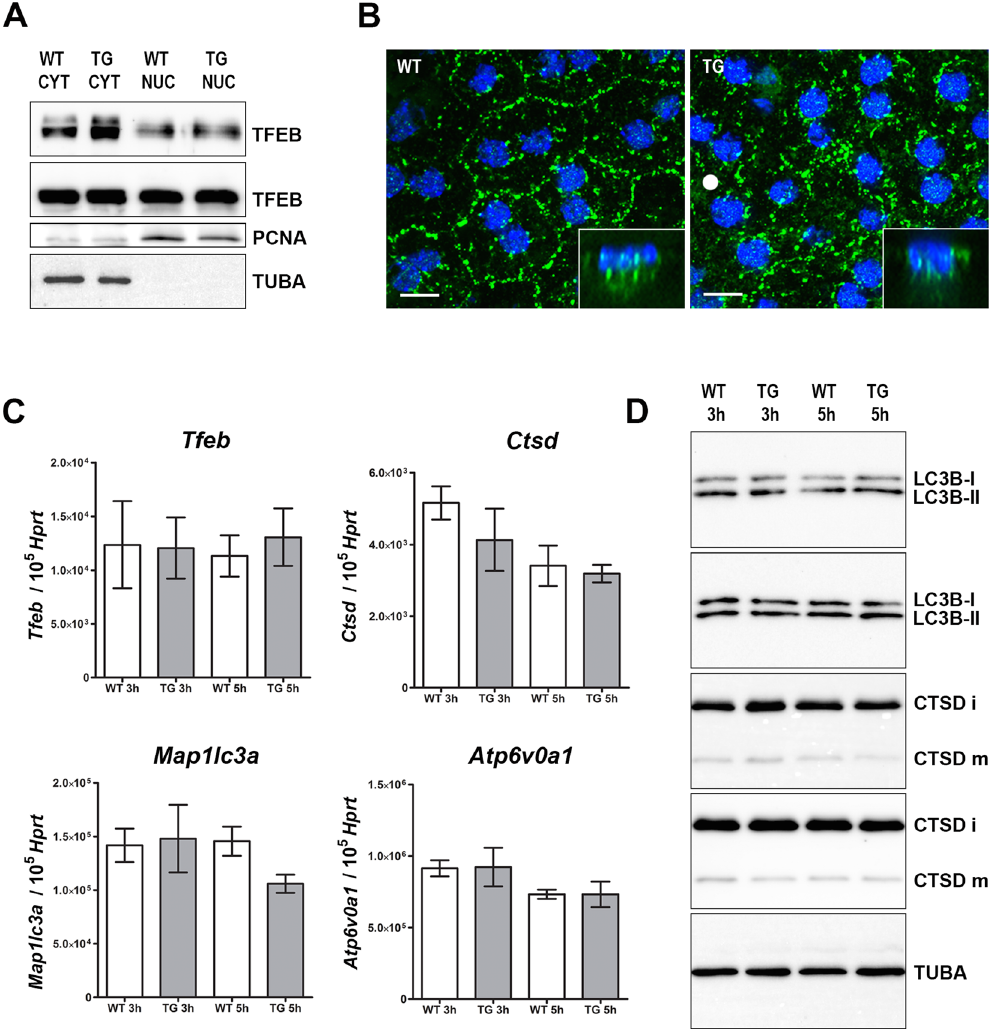
Figure 2. Autophagy-lysosomal pathway genes and proteins have normal expression levels. ( A ) Immunoblots of TFEB, PCNA and TUBA using cytoplasmic proteins (5 µ g per lane) and nuclear proteins (2 µ g per lane) from RPE homogenates prepared 2 hours after light onset (7AM). ( B ) Representatives confocal images of TFEB (green) and DAPI (blue) immunochemistry in WT (left) and TG (right) mice (Scale bar: 10 µ m). ( C ) Histogram showing relative Tfeb , Map1lc3a , Ctsd and Atp6v0a1 mRNA levels in the RPE by qRT-PCR. Each mRNA level was normalized to Hprt . Total RNA was prepared 3 hours (8AM) and 5 hours (10AM) after light onset. Data represent mean ± SEM; n = 5–8 mice per group. ( D ) Immunoblots of LC3B-I/LC3B-II, CTSD (i, immature and m, mature) and TUBA using RPE homogenates prepared 3 hours (8AM) and 5 hours (10AM) after light